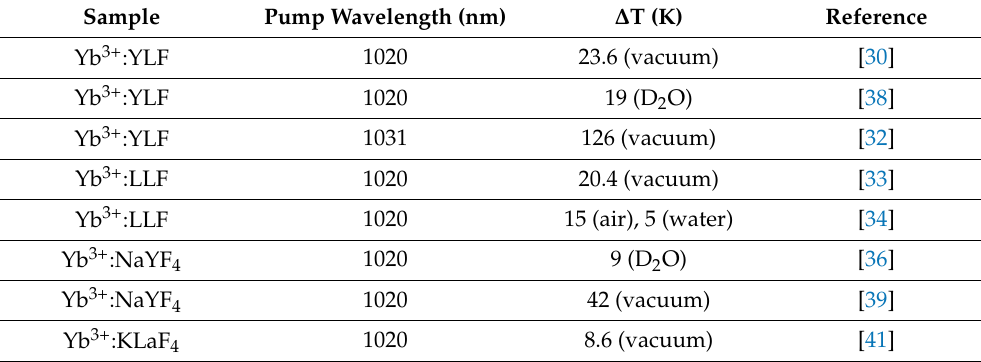
Table 1. Reported results in optical refrigeration of nanoparticles. ΔT (K) is the temperature drop.